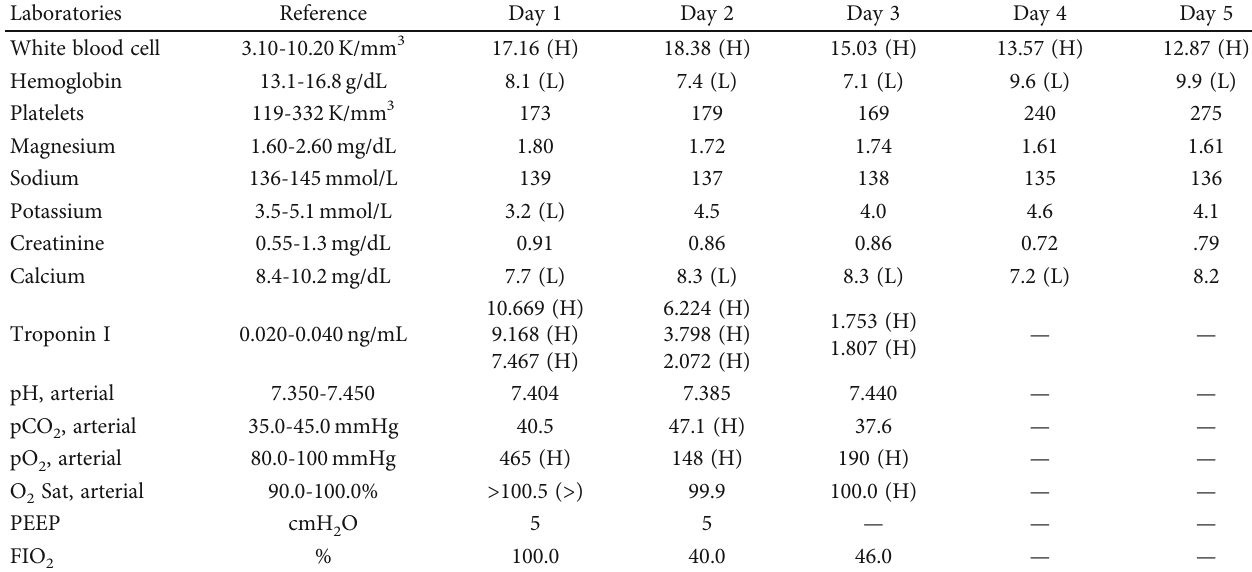
Table 1: Important laboratory